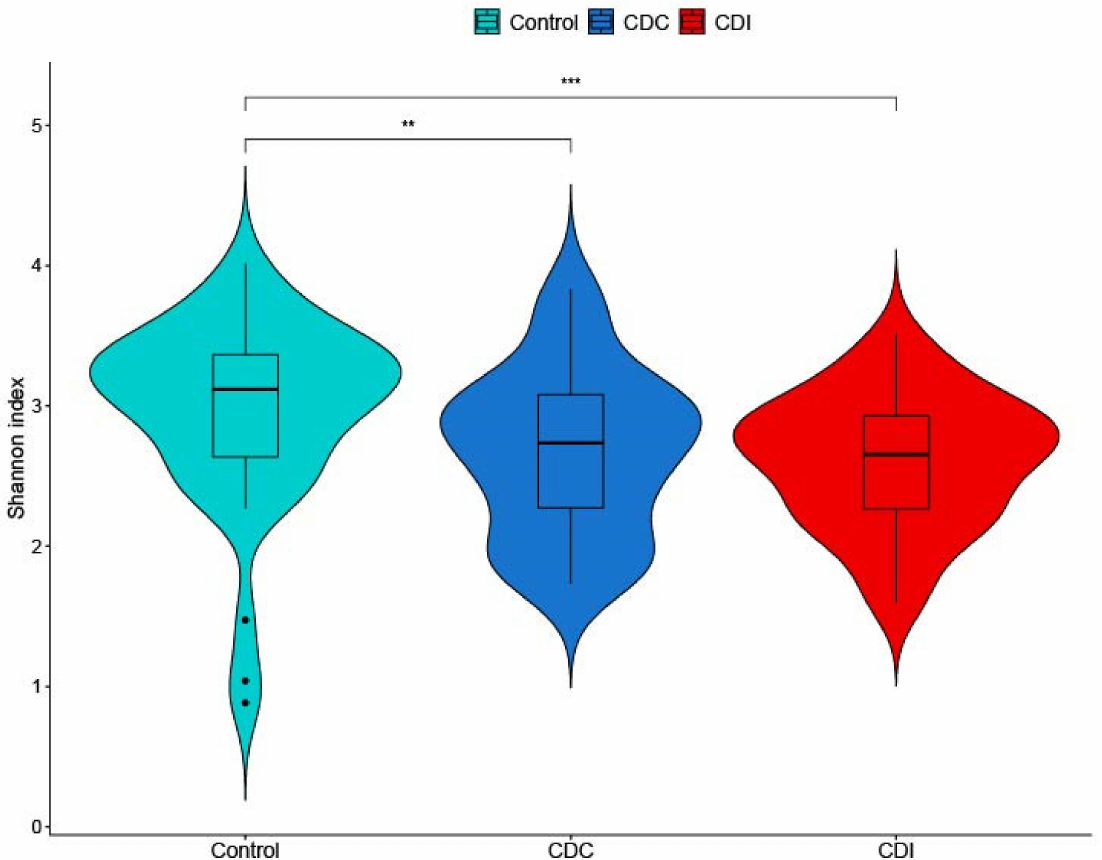
Figure 1. Violin plot of alpha diversity, as measured by the Shannon index, in control, C. di ffi cile colonization (CDC) and C. di ffi cile infection (CDI) patients. The box plot shows the median, 25th, and